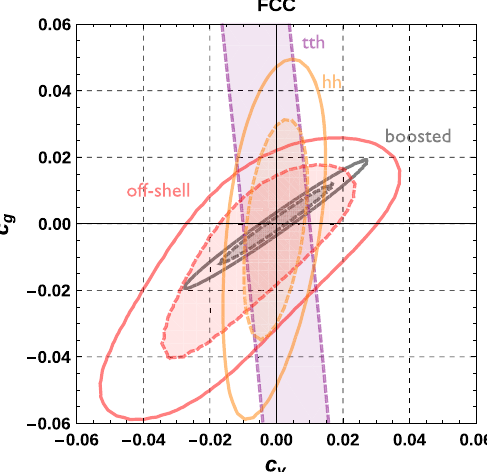
Fig. 8.6 95% (solid) and 68% (dashed) exclusion contours in the (top Yukawa, Higgs-gluon contact interaction) plane obtained from FCC-hh projections. Red corresponds to off-shell, gray to boosted and orange to double Higgs production, while the purple band indicates the 68% region from t ¯ tH. From Ref.